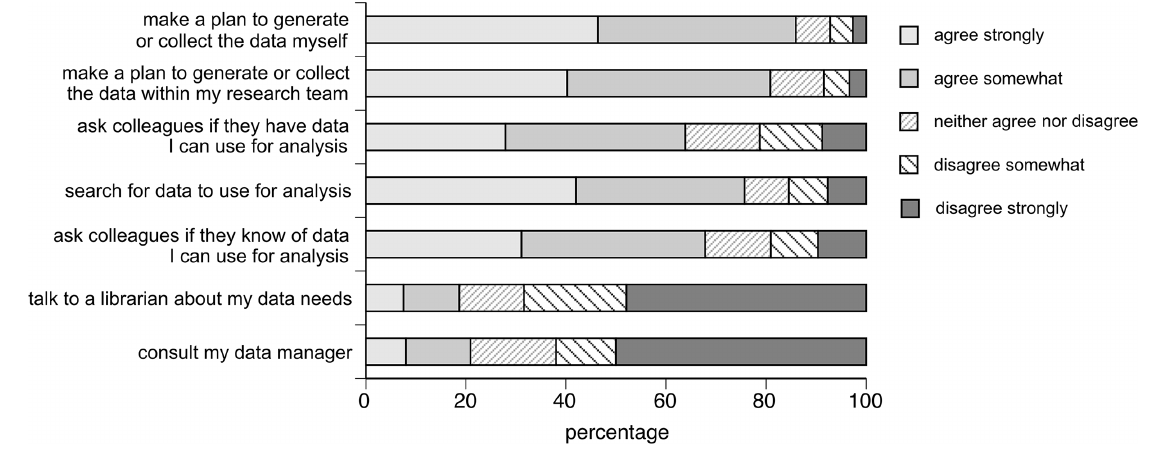
Fig 4. When I need to analyze data to answer a researchquestion, I ... (N = 569/ 569/ 570/ 576/ 572/ 557/ 526).